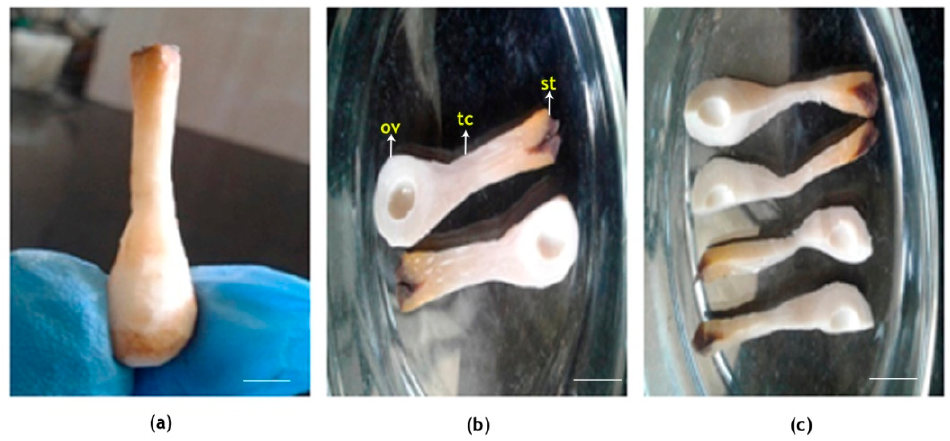
Figure 9. Dissection of coconut female flower. Outer calyx and exodermis completely peeled off, showing ( a ) intact longitudinal part; ( b ) two halves showing stigma, tubular canal and ovule-bearing region; and ( c ) small longitudinal sections. St, stigma; tc, tubular canal; ov, ovule. Scale bar = 5 mm.